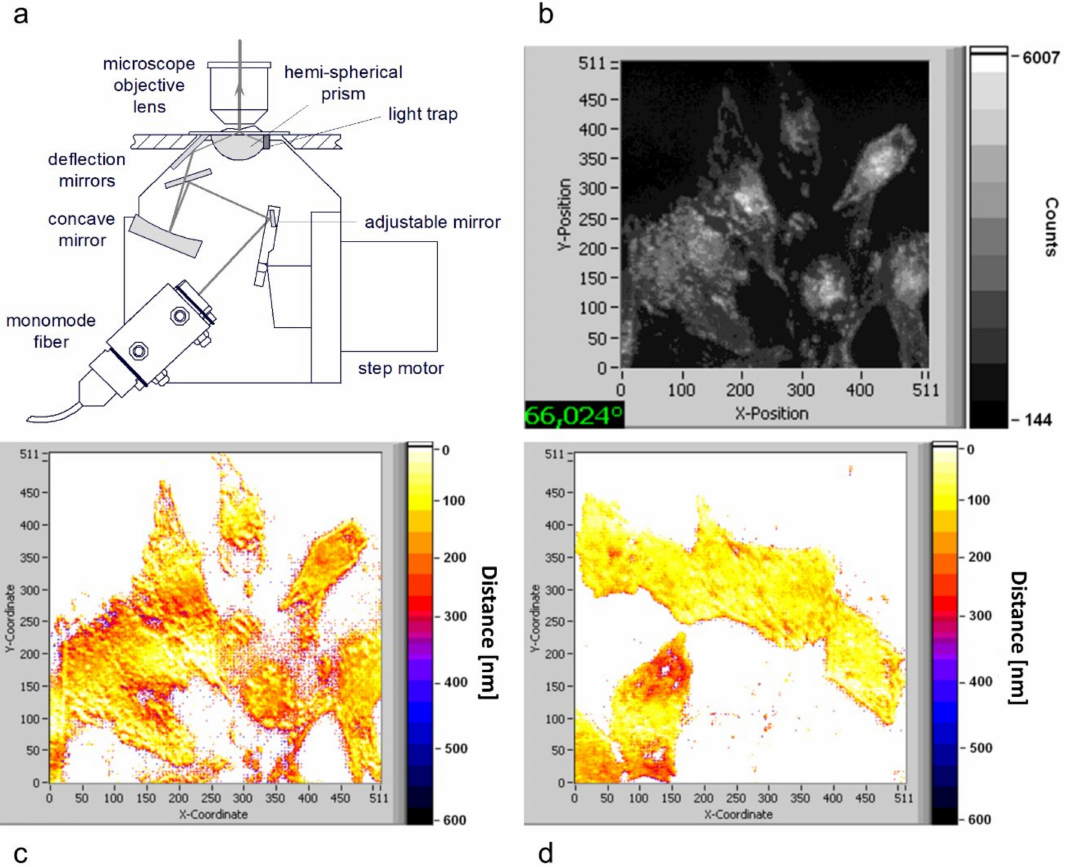
Figure 8. ( a ) Illumination device for variable-angle TIRFM; ( b ) single TIRFM image of U251-MG glioblastoma cells incubated with the fluorescence marker laurdan (8 µ m; 60 min) for θ = 66 ◦ ; ( c ) cell–substrate distances in the range of 0–600 nm calculated from variable-angle TIRFM for the U251-MG wild type, and ( d ) the same for U251-MG with activated TP53 suppressor gene. Excitation wavelength: λ 0 = 391 nm, detection range: λ D Reproduced from Ref. [51] with